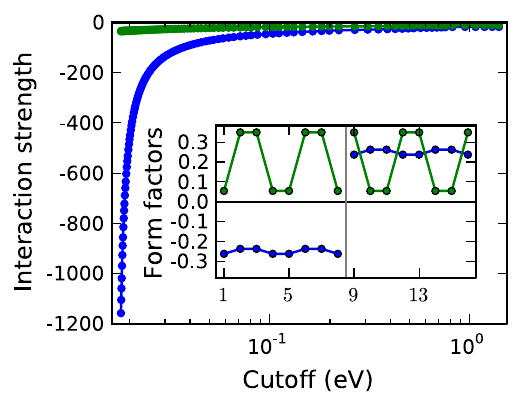
FIG. 9. Typical RG flows and the superconducting gaps asso- ciated with the Fermi surfaces for the two-pocket scenario with Þ ¼ ð 0 : 5 ; 0 : 1 Þ eV . Leading form factor is denoted in blue, ð J ;J 1 2 subleading form factor in